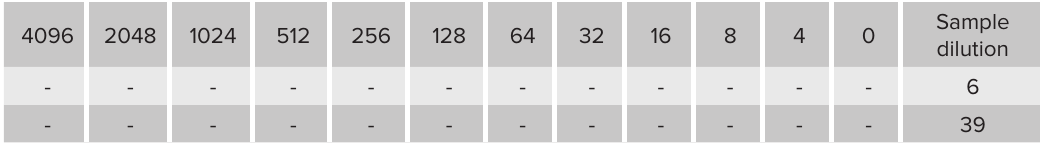
Table 2: Antibiotic Susceptibility of Vancomycin-Resistant Strains and Determination of MIC And MBC.